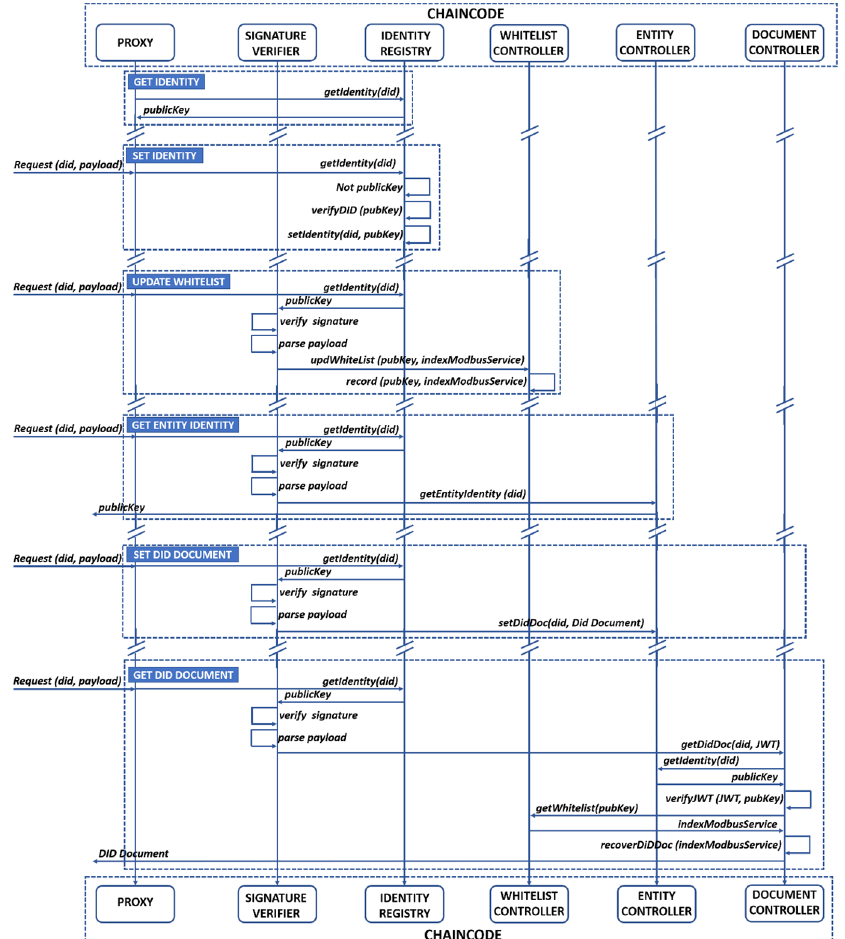
Figure 2. Chaincode design.